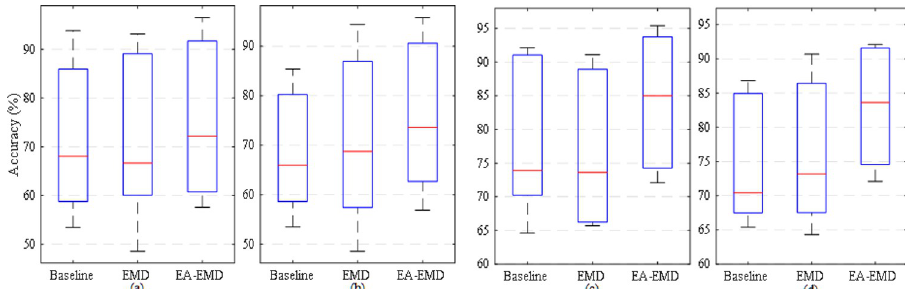
Fig 9. The maximal, the minimal and the median value of the averaged classification accuracies across all subjects in each or the two data sets yielded by the three algorithms Baseline, EMD and EA-EMD for (a) data set 1 and classifier LDA, (b) data set 1 and classifier LA, (c) data set 2 and classifier LDA, and (d) data set 2 and classifier LA.